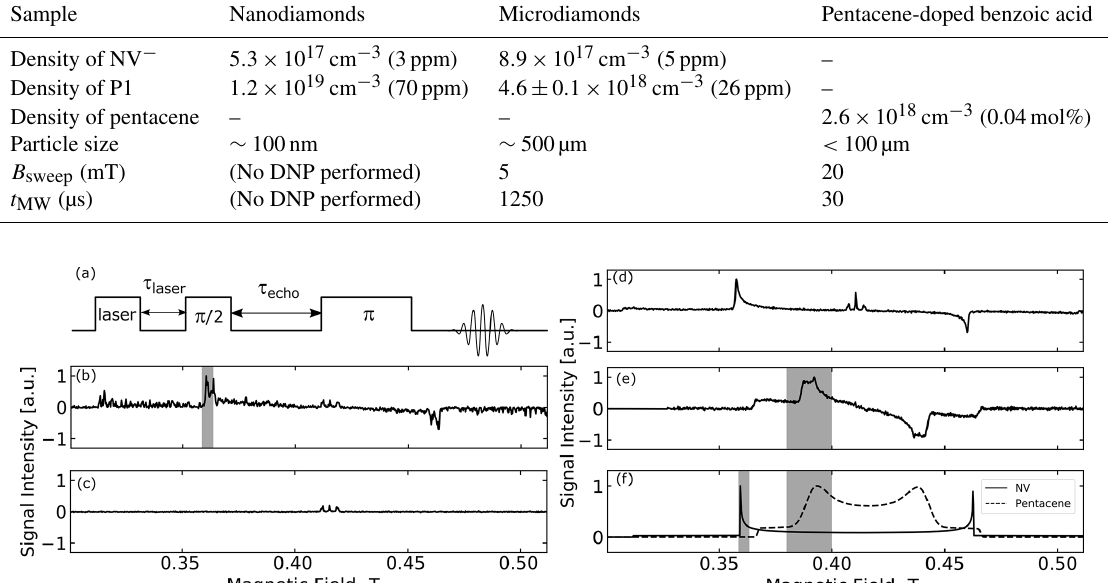
Table 2. Summary of sample conditions and the optimized parameters of the DNP experiments.